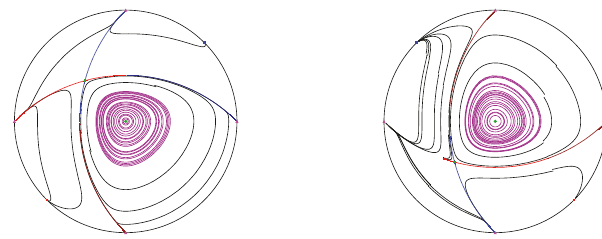
Figure 2: The phase plane of system (16) when 𝑏 = 1, 𝑐 = 1 or 𝑏 = 1, 𝑐 = −1.